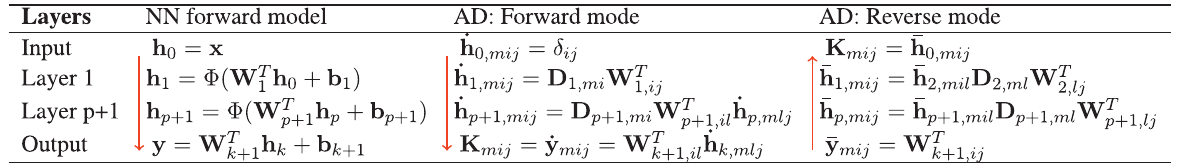
TABLE 3 | NN forward model and its Jacobian matrix computed by the forward mode and reverse mode of automatic differentiation (AD). The arrows indicate the order of steps for each process.